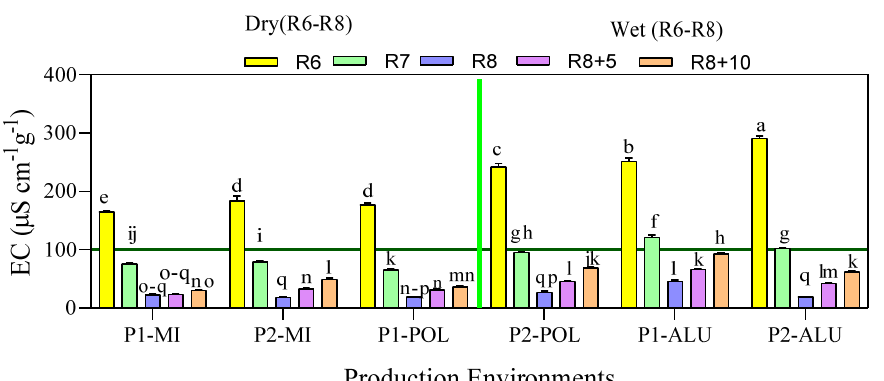
Figure 4. Electrical conductivity (EC) ( µ Scm − 1 g − 1 ) as affected by the interaction between the production environment (location × planting cycle) and maturity groups. Means followed by the same letters do not differ significantly between the production environments × maturity group using Ls means at p < 0.05. Wet and dry were grouped based on the late reproductive stage environmental condition.